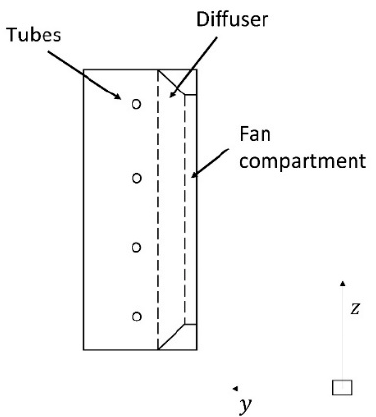
Figure 5. Schematic structure of the third level of the numerical model. From the right to the left, the third level is composed by the fan compartment, the diffuser and the tubes. The air flows through the heat exchanger along the y-direction. The supply tubes are arranged along the z-direction.